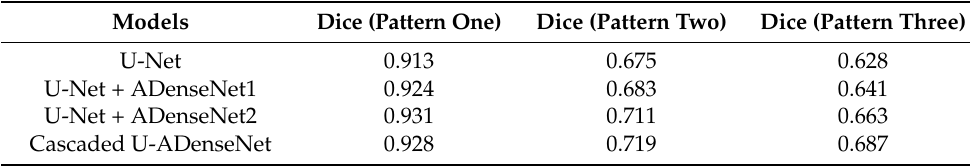
Table 2. Comparison of results in the different patterns of morphological liver tumors.